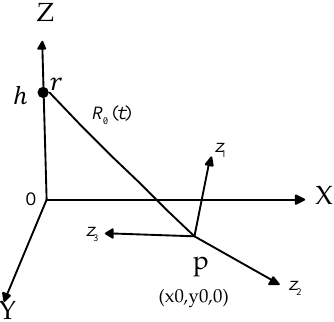
Figure 3. Geometry of the ISAR system.